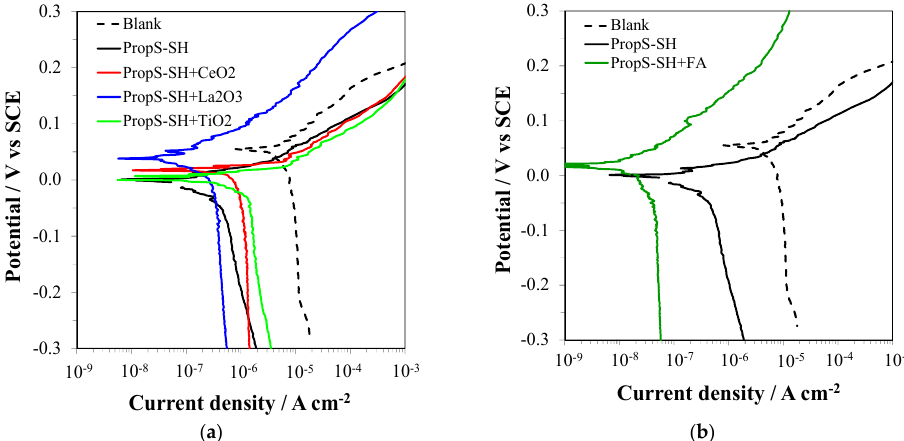
Figure 5. Polarization curves recorded after 20 days of immersion in AR × 10 at 30 °C, on bare (blank) and coated bronze. The coatings include plain PropS-SH and PropS-SH containing CeO 2 , La 2 O 3 , or TiO 2 nanoparticles ( a ) and FA microparticles ( b ). Conditions of coating preparation: 30-day storage time of the silane solution at 4 °C, 10 day curing at RT. Table 4. Corrosion potentials ( E cor ) and corrosion current densities ( i cor ) obtained on particle- containing PropS-SH coatings after 20 days of immersion in AR × 10 at 30 °C. η corresponds to the increase in protection efficiency afforded by particle charging.